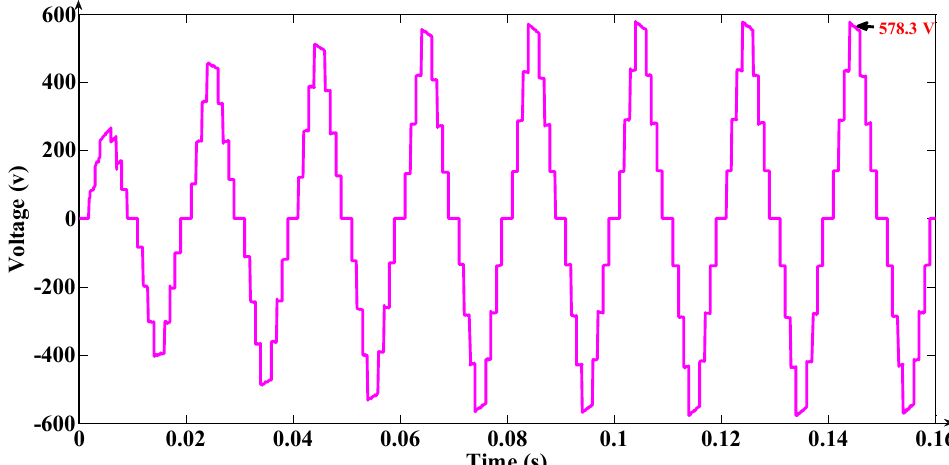
Figure 53. Output voltage ripple waveform for hybrid controller-4-based BDC.